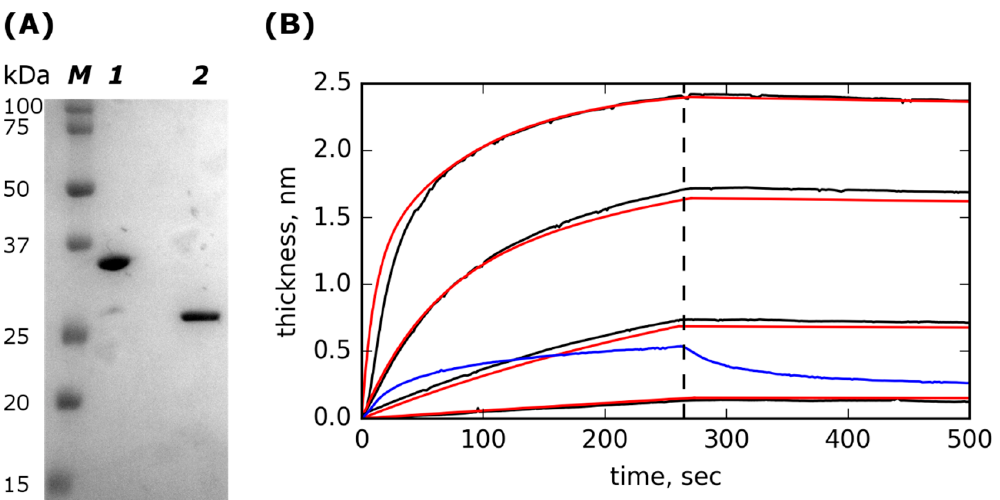
Figure 1. SDS-PAGE of purified Lst-ABD and kinetics of rat serum albumin (RSA) interactions with the immobilized Lst-ABD. ( A ) SDS-PAGE of purified Lst-ABD (lane 1) and lysostaphin (lane 2); lane M contains molecular mass standards with their molecular masses indicated on the left. ( B ) Kinetics of rat serum albumin (RSA) interactions with the immobilized Lst-ABD. Experimental curves corresponding to different concentrations of RSA in the solution are shown in black, fitted theoretical curves are shown in red; concentrations of RSA are (top to bottom) 250, 42, 7, and 1.2 µg/mL. The dashed vertical line marks the end of the association phase and the start of the dissociation phase. The binding and dissociation of 1 mg/mL bovine serum albumin (BSA) are shown in blue. Table 1. Parameters of RSA interaction with immobilized Lst-ABD